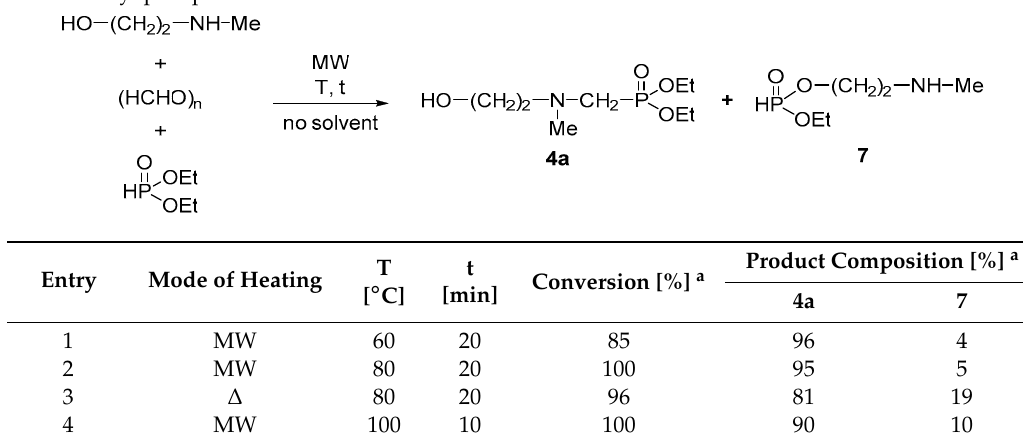
Table 1. Optimization of the condensation of N -methylethanolamine, paraformaldehyde, and diethyl phosphite.